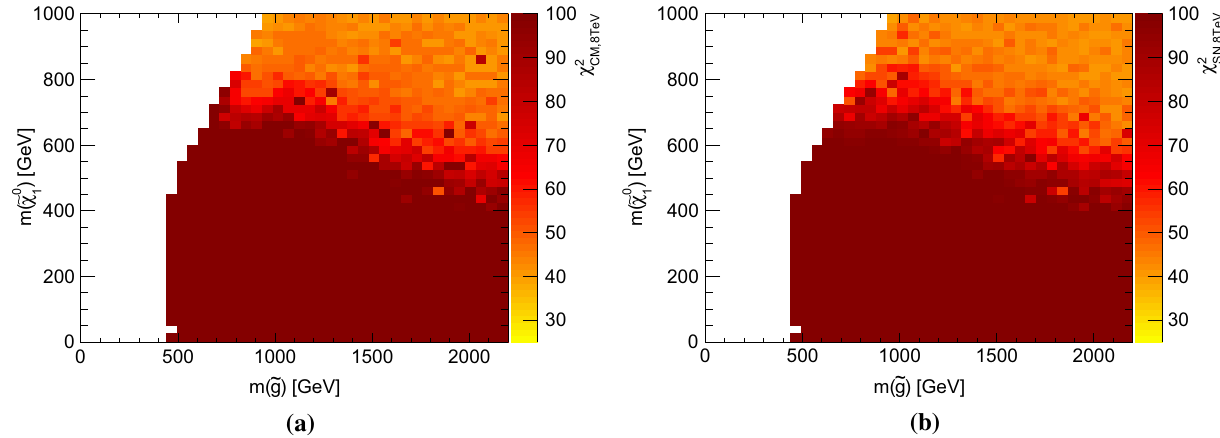
Fig. 8 MaximumpMSSM-11 χ 2 inthegluino–neutralinomassplaneforthe8TeVvalidationsetfortheCheckMATEresults( a )andthepredictions of SCYNet ( b )